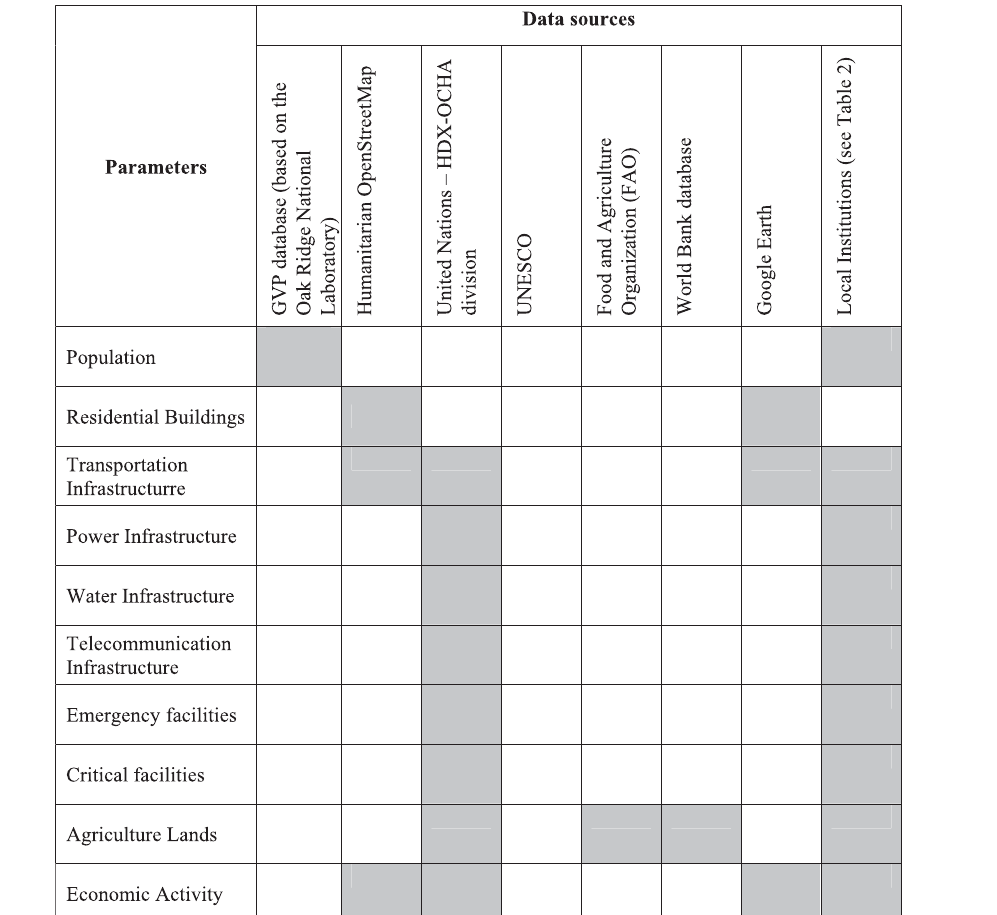
TABLE 3 | List of the sources used for data acquisition on the parameters of the exposure and vulnerability factors.